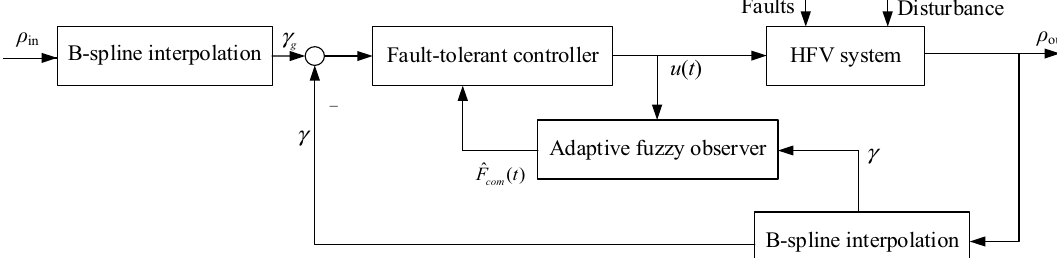
Figure 2. Block diagram of fault-tolerant